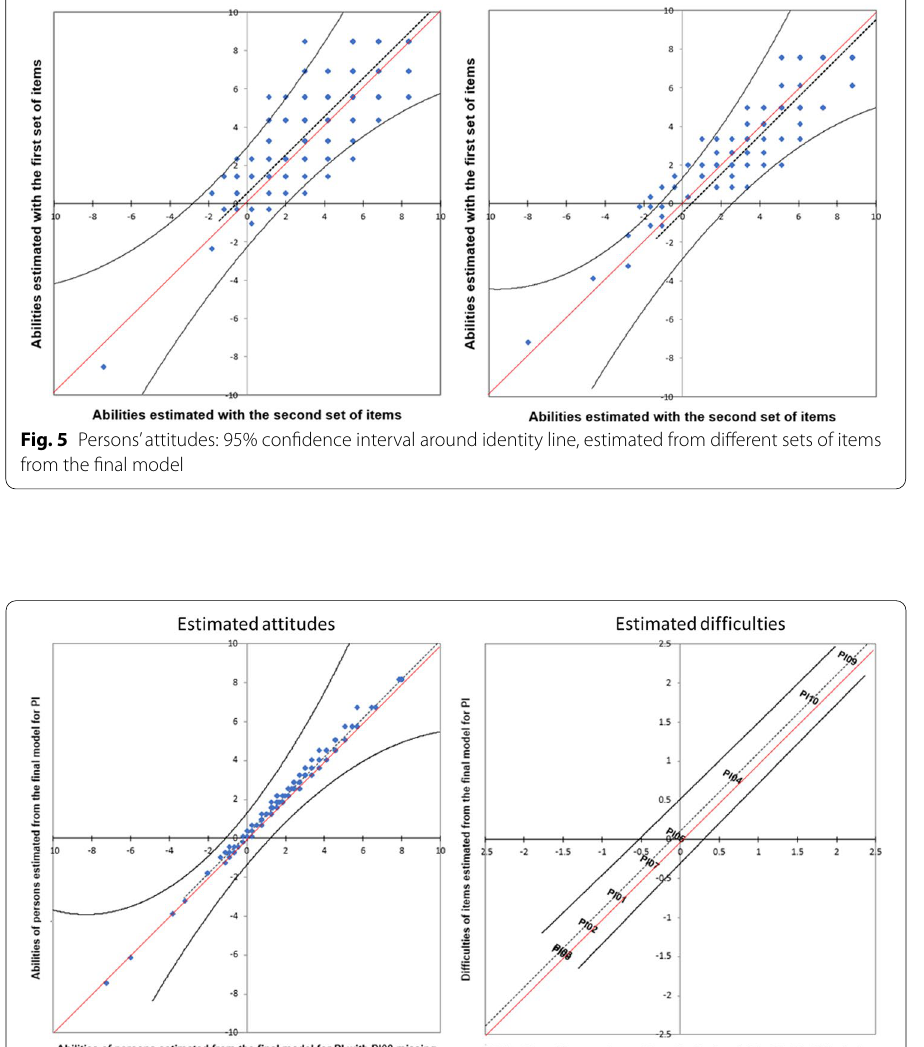
Fig. 6 Dimension PI: 95% interval around the identity line with and without item PI08